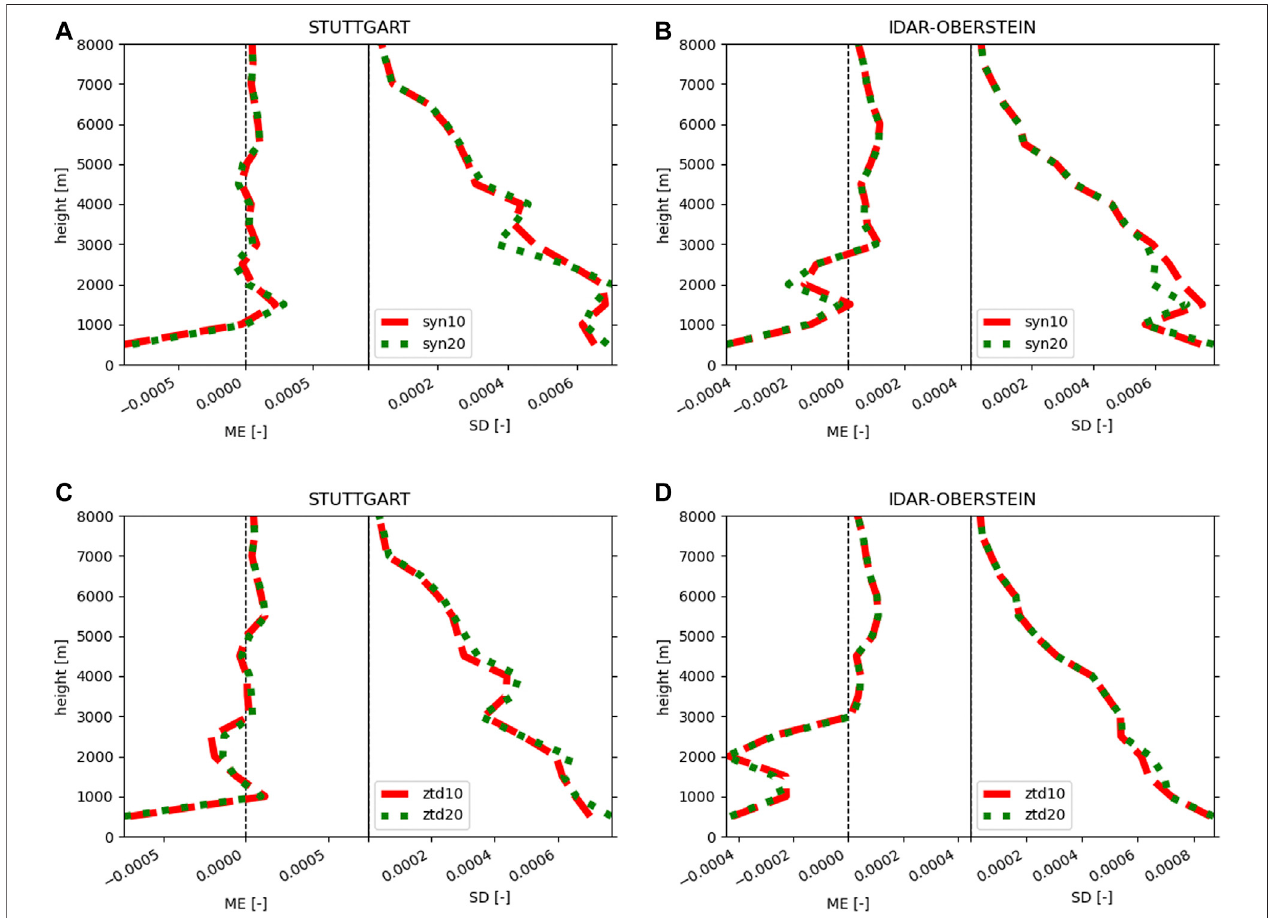
FIGURE 4 | Mean error and standard deviation of the mixing ratio pro fi le for the spring episode comparing the assimilation of synoptic data with thinning distances of 10 km (red) and 20 km (green) with radiosonde data from Stuttgart (A) , Idar-Oberstein (B) and the respective results for assimilating ZTD for both locations (C,D) .